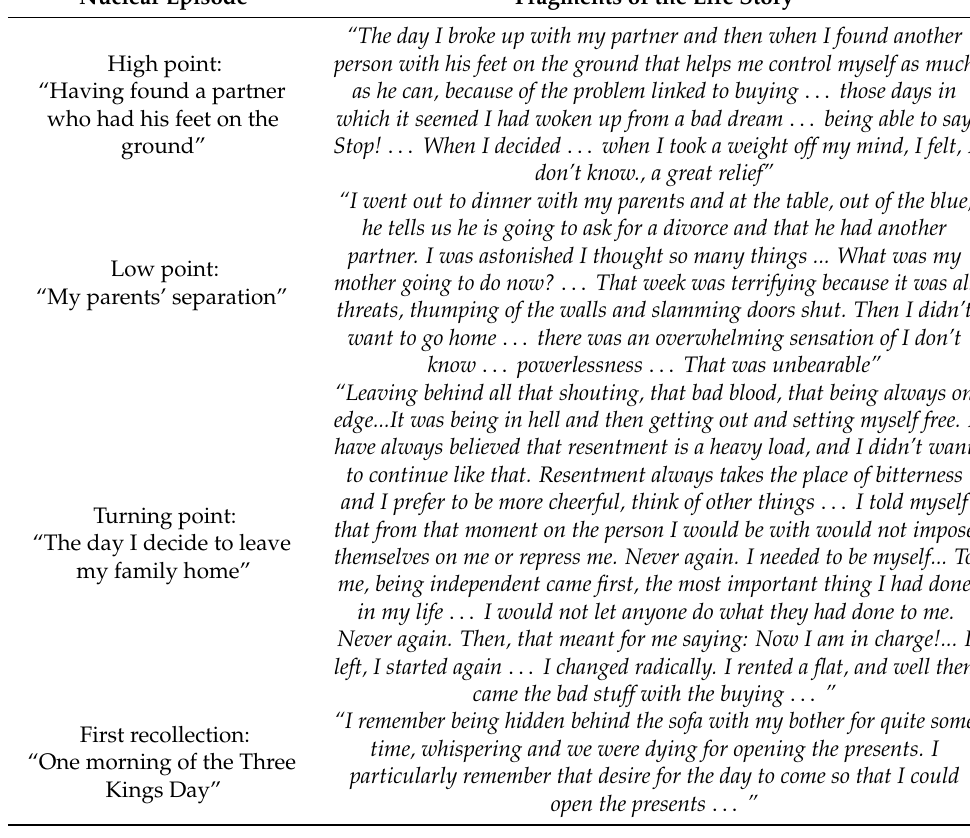
Table 1. Nuclear episodes in the life story of “She” and fragments of the life